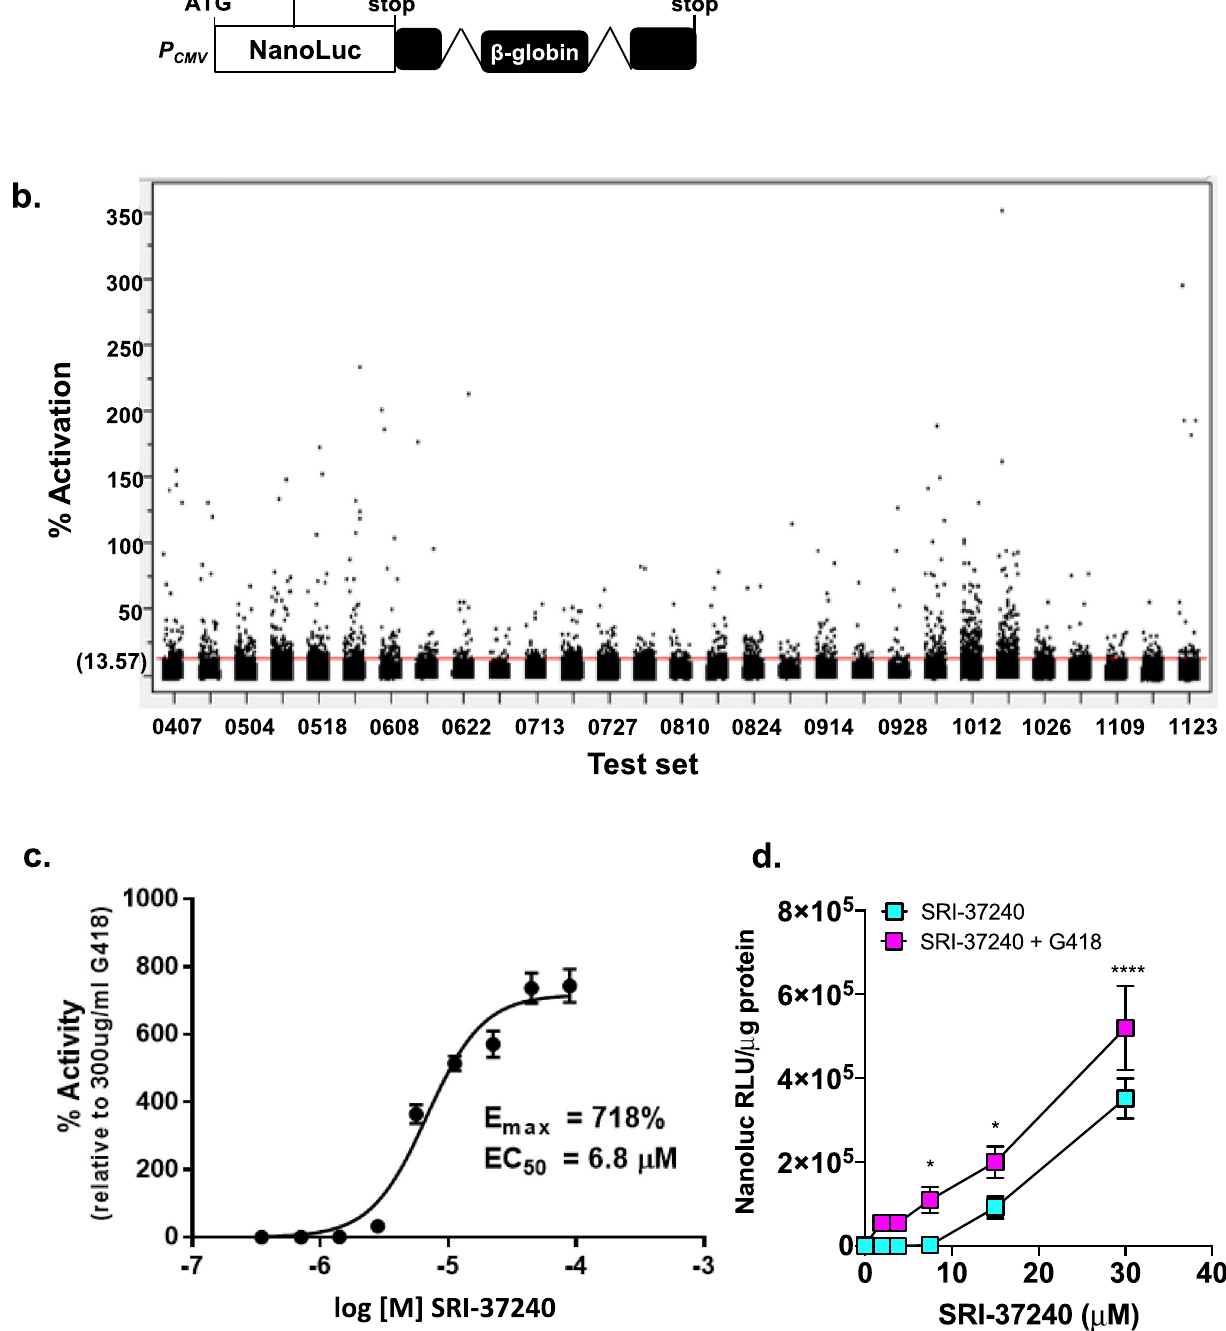
Fig. 1 Identi fi cation and characterization of novel readthrough agents using an RT/NMD NanoLuc reporter in FRT cells. a The reporter used to perform HTS. b Scatter plot of HTS results using the reporter cell line. The screen was comprised of 29 test sets. Hit compounds were de fi ned as those with activity ≥ mean ± 3 SD of all test compound data (13.57%). Six data points are off-scale (460 – 2900%) and are not shown. Concentration-response data for c SRI-37240 alone (mean of 2 replicates, bars indicate range) and d comparison of SRI-37240 alone and combined with 100 μ g/mL G418 in FRT cells expressing the NanoLuc RT/NMD reporter. In panel c , the NanoLuc activity is expressed as the percent (mean ± SD) of the signal generated by the positive control (300 μ g/mL G418). In panel d , the NanoLuc activity is normalized to total cellular protein. Two-way ANOVA was used to compare NanoLuc activity (mean + /- SD) in cells treated with both SRI-37240 and G418 to cells treated with SRI-37240 alone ( n = 4; * p < 0.05 and **** p < 0.0001). Source data is available as a source data fi le.